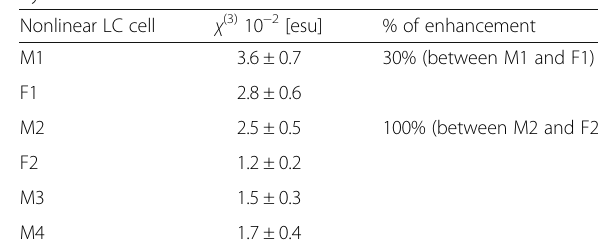
Table 2 Maximum values of nonlinear susceptibility of